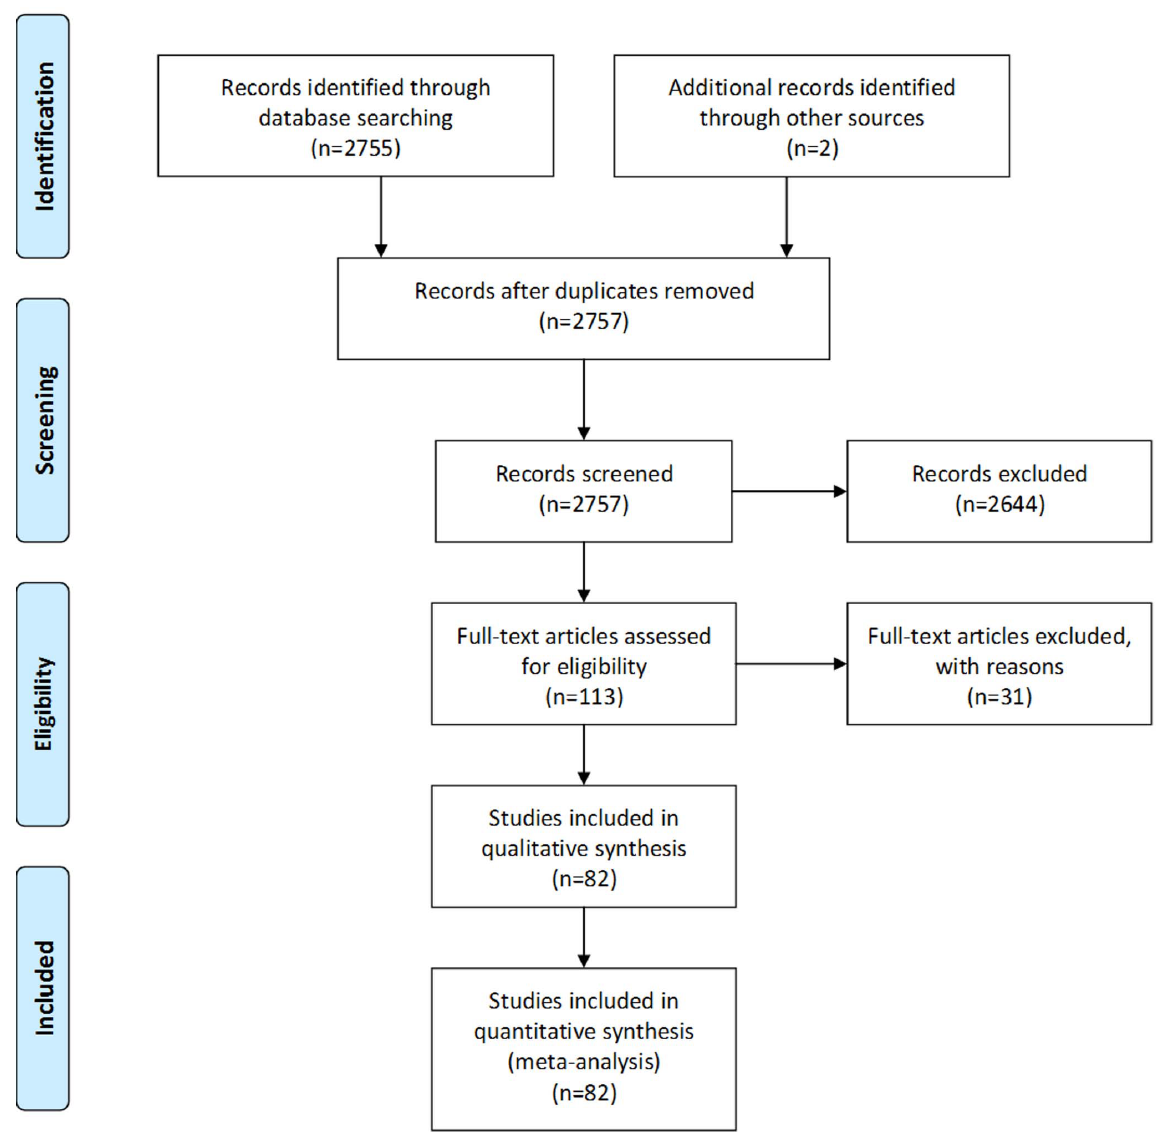
Figure 1. PRISMA flow diagram for the intussusception literature review.